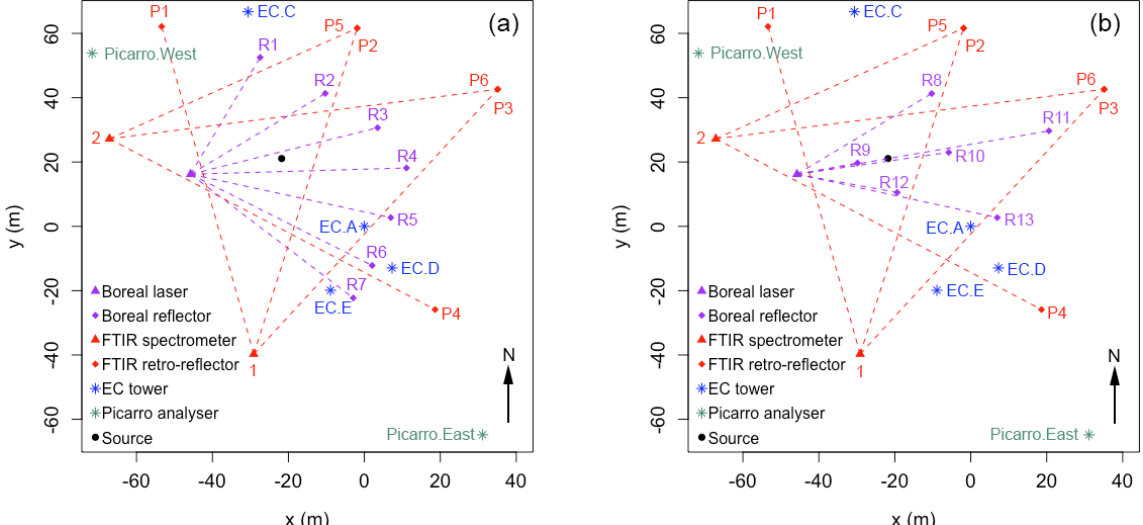
Figure 1. (a) Layout of instruments in the 2015 Ginninderra release experiment between 21 May and 7 June 2015. (b) Layout of instruments between 8 and 12 June 2015. R1 to R13 are the paths formed between the Boreal laser and reflectors; P1 to P6 are the paths formed between the FTIR spectrometers and retro-reflectors; EC.A to EC.E are the EC towers; and Picarro.East and Picarro.West are the Picarro analysers. All coordinates are relative to EC.A, which is situated at the